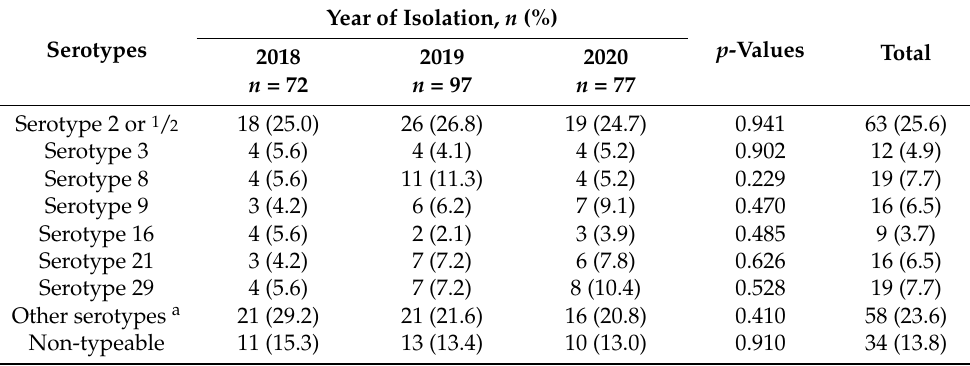
Table 1. Distribution of S. suis strains according to serotype and isolation